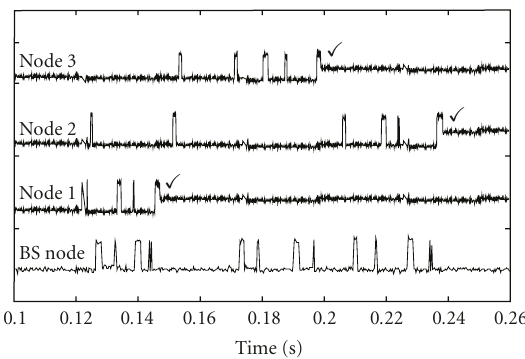
Figure 9: AAO using three nodes and a coordinator over